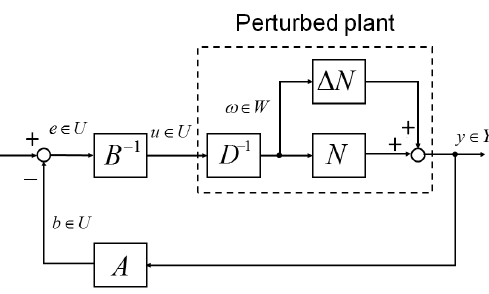
Figure 6. Nonlinear feedback control